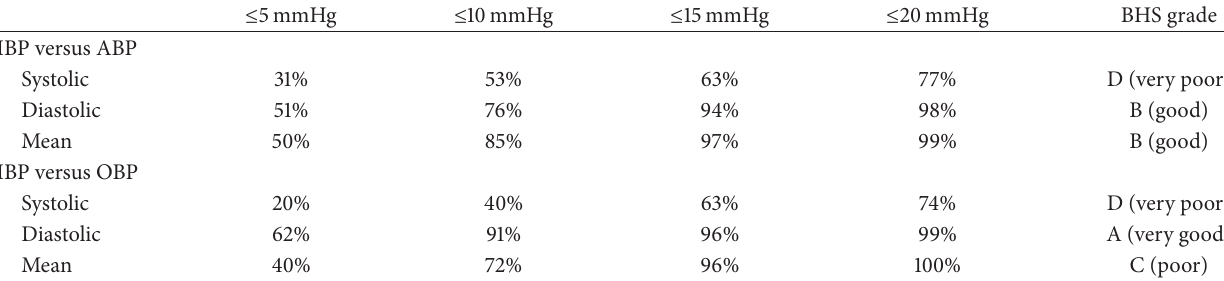
Table 2: BHS grade of agreement between noninvasive and direct-invasive methods: cumulative percentage of absolute difference (mmHg) between IBP and other studied methods (ABP and OBP). Grades are derived from percentages of readings within 5, 10, and 15mmHg: to achieve a grade, all three percentages must be equal to or greater than the tabulated values. For example, to achieve the “A” grade, sixty percent of the measured BP values with IBP and ABP must be within 5 mmHg, 85% within 10 mmHg, and 95% within 15mmHg. The limit of ≤ 20 mmHg does not belong to the BHS criteria and has been inserted to highlight in particular the poor agreement for